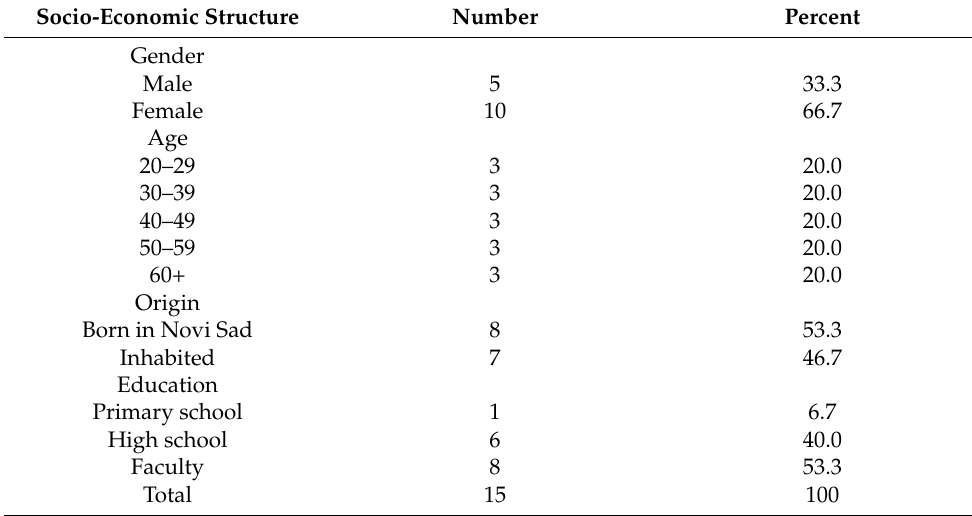
Table 1. Socio-economic structure of